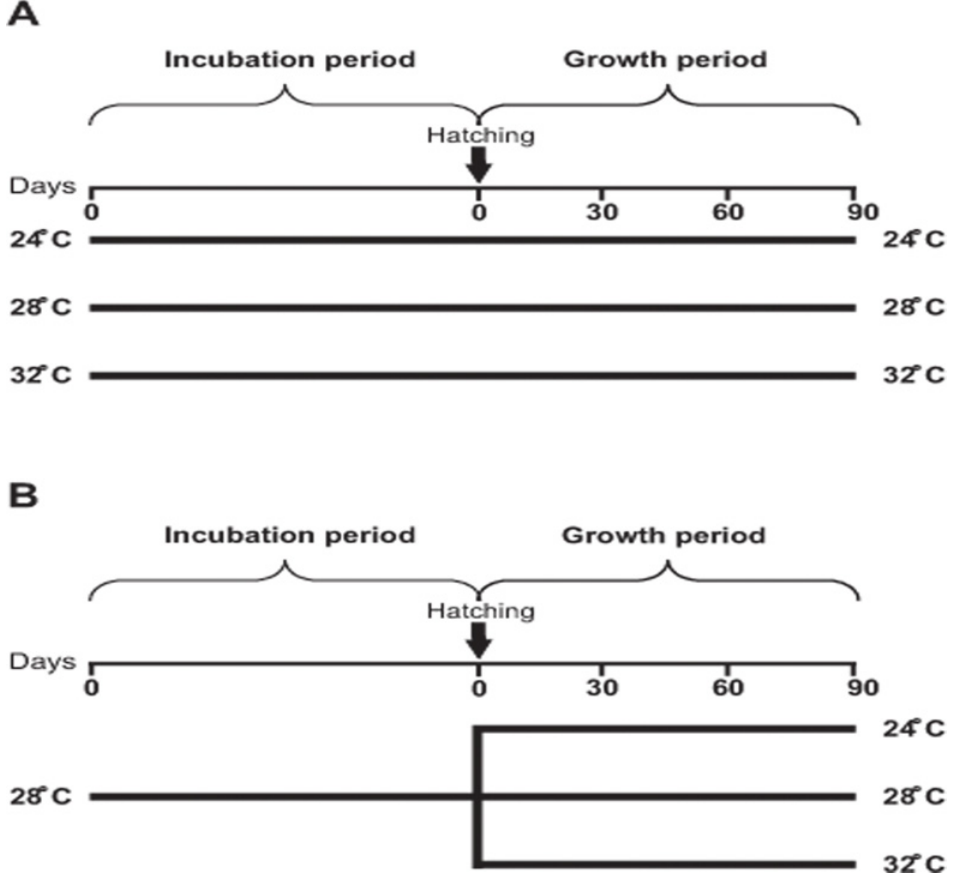
Fig 1. General schedule of the protocols applied in the two experiments performed. In Experiment 1 (A) Neocaridina heteropoda heteropoda juveniles grew at the same temperature at which they were incubated as embryos (24, 28 or 32°C), while in Experiment 2 (B) embryos were incubated at 28°C, but juveniles grew either at 24, 28 or 32°C. The duration of the Incubation period varied according to temperature, while the duration of the Growth period was 90 days. Day 0 of the Incubation period was the spawning